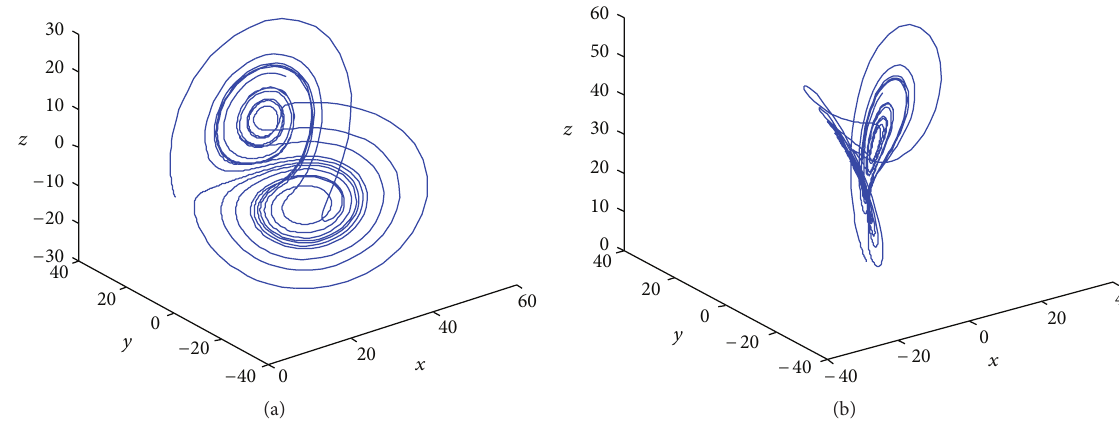
Figure 1: Strange attractors of the original Lorenz chaotic